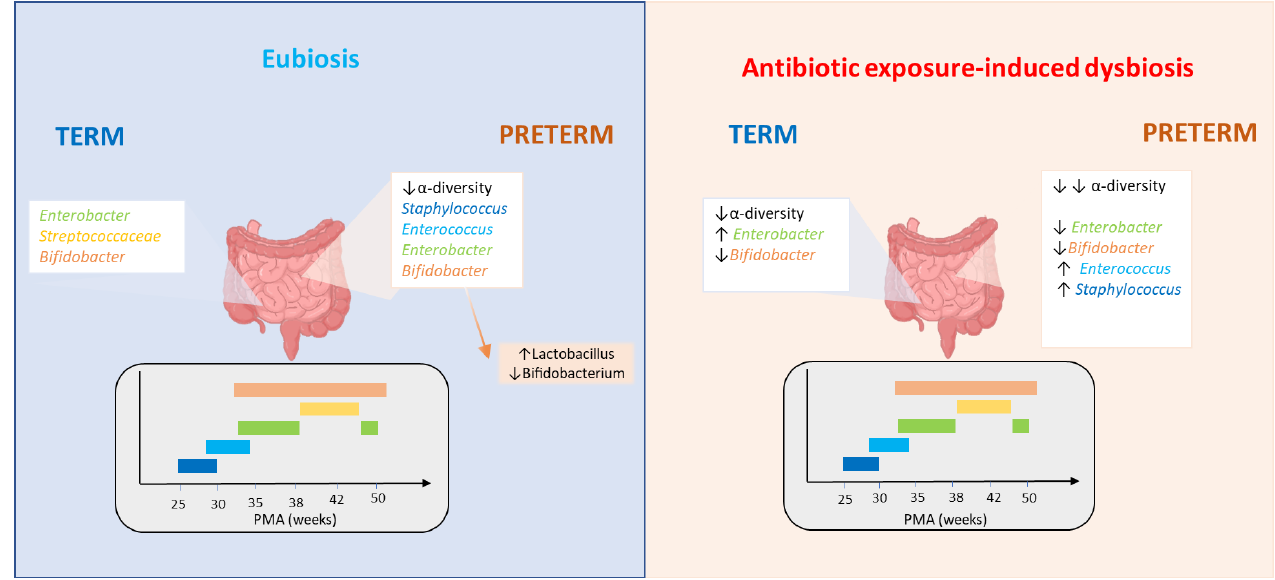
Figure 1. Effects of antibiotic therapy on neonatal gut microbiota according to postmenstrual age (PMA). In the blue box (eubiosis conditions) the colors in the graph indicate the expression of the relevant bacterial species in term and preterm infants according to PMA. The pink box represents the bacterial changes induced by antibiotic exposure in term and preterm infants according to PMA.